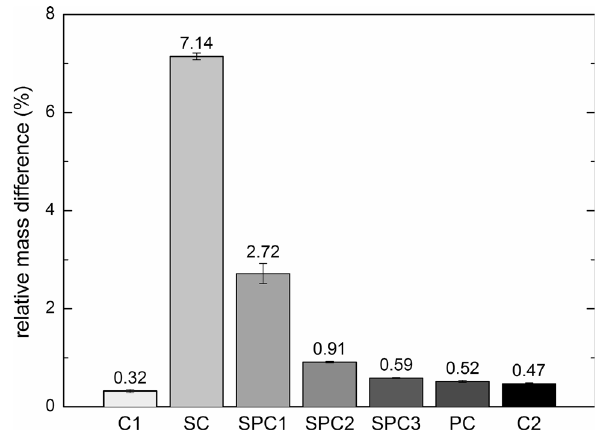
Fig. 6 Relative increase/decrease in sample weight after salt crystallization test.